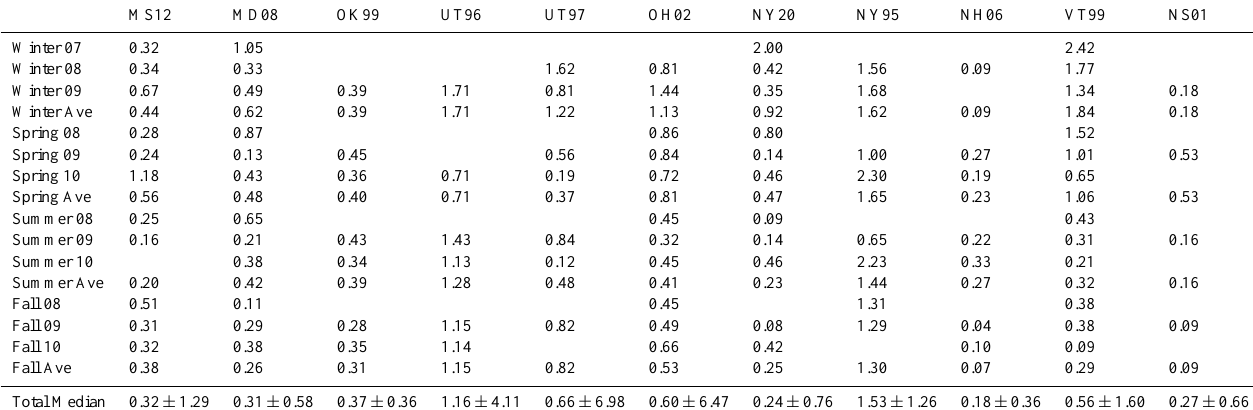
Table 4. The seasonal and total medians of PBM at 11 AMNet